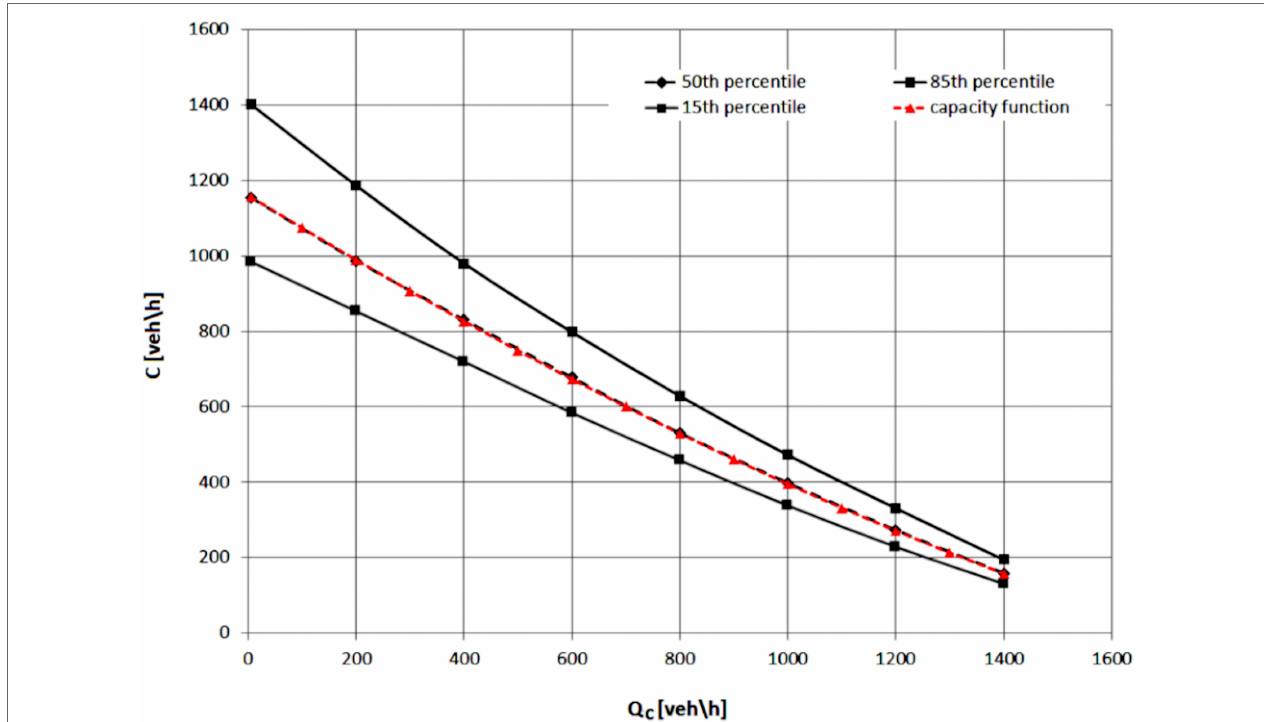
FIGURE 2 | Uncertainty in capacity estimation at single-lane roundabouts {note that the capacity equation in figure is calculated by using the mean critical and follow-up headways provided by the meta-analysis [see Giuffrè et al. (2016)]} .